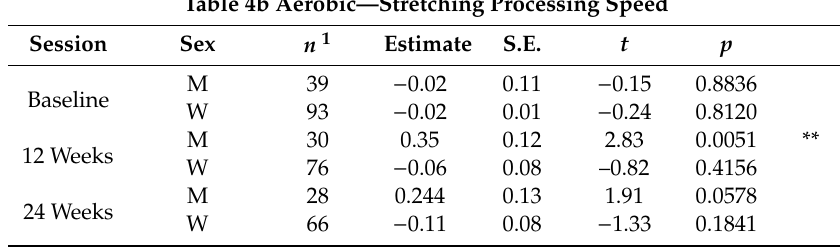
Table 4b Aerobic—Stretching Processing